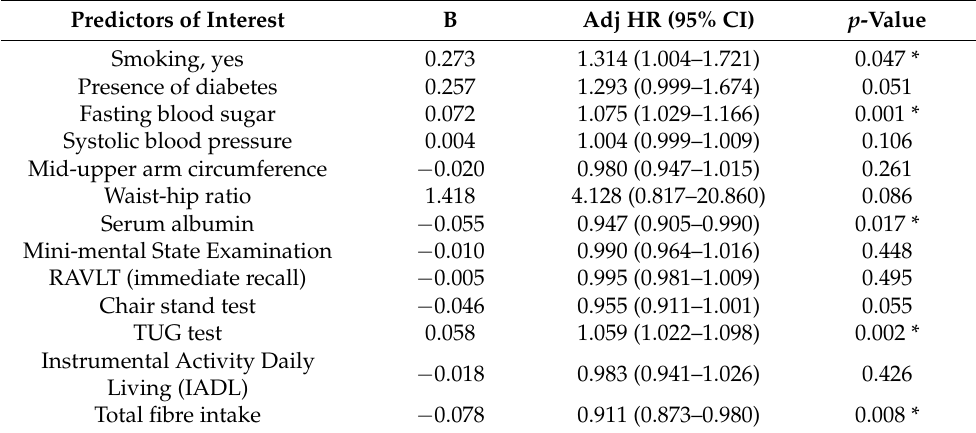
Table 6. Potential predictors for mortality at five